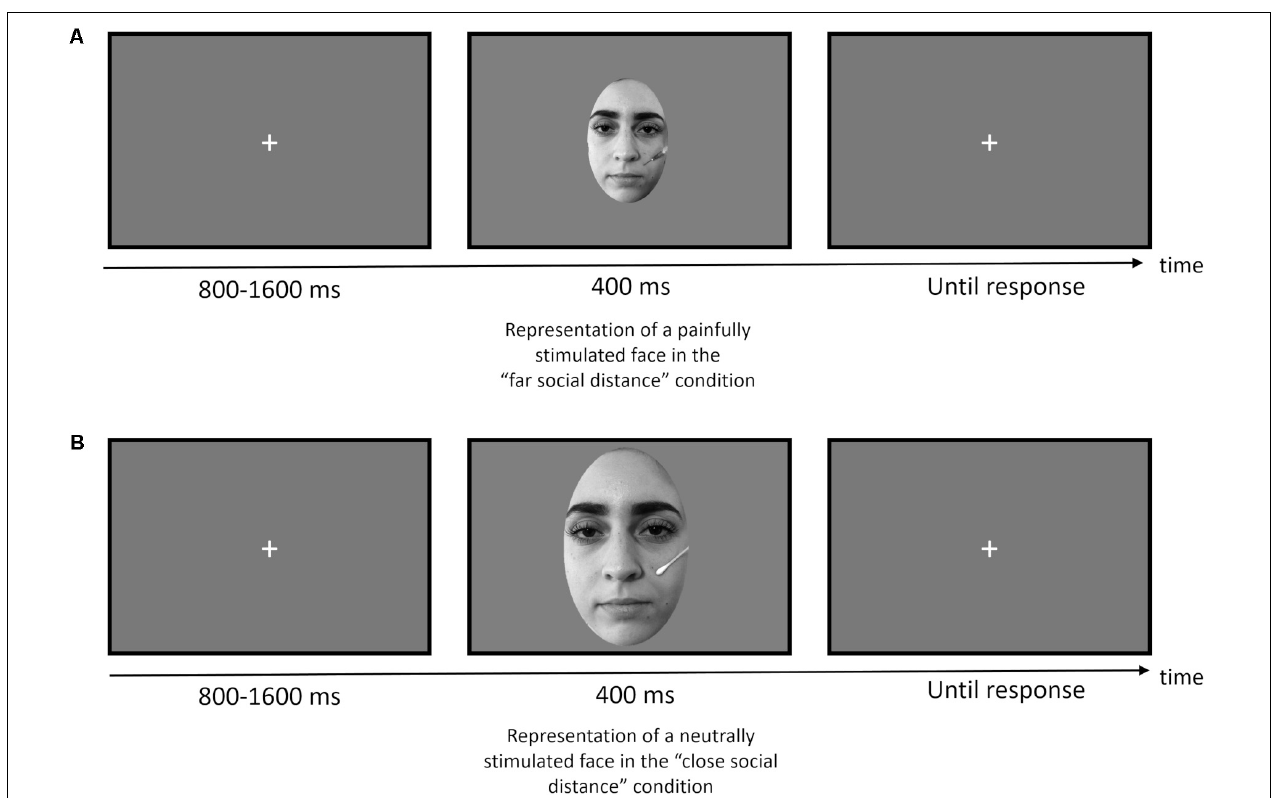
FIGURE 1 | Timeline of each trial for Experiment 1 (pain decision task): (A) example of a trial for the far social distance condition with a painfully stimulated face; (B) example of a trial for the close social distance condition with a neutrally stimulated face. Original face stimuli have been replaced in (A,B) with actors according to the terms of use of the Eberhardt Lab Face